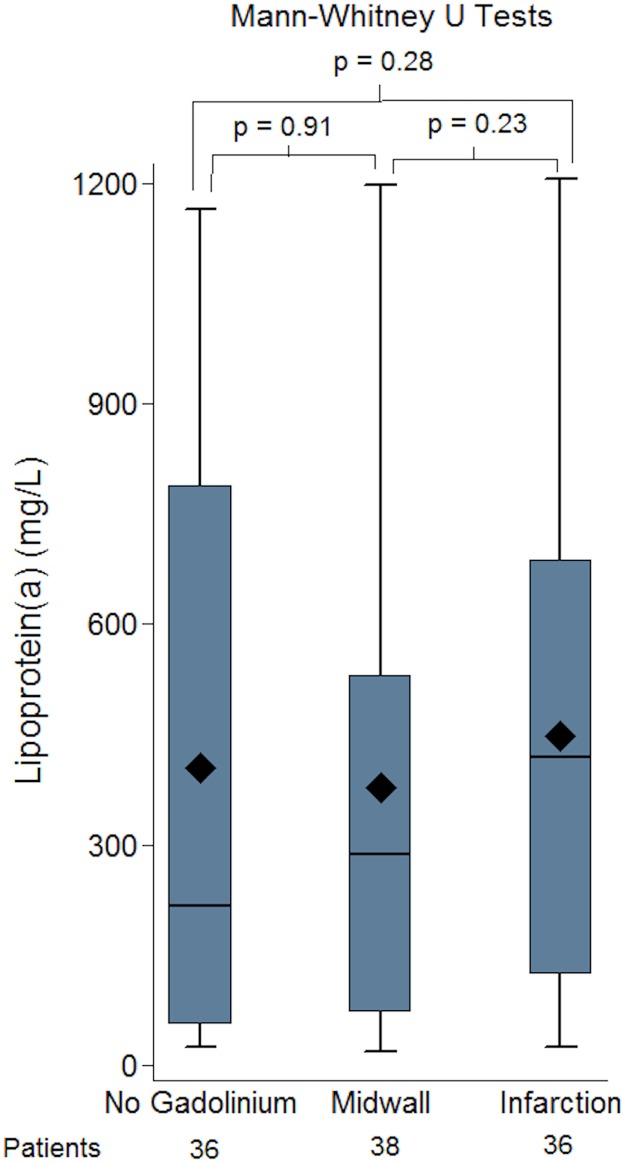
Values in the three groups (no fibrosis/no gadolinium, midwall fibrosis, infarction fibrosis) were compared and no significant difference between the groups was identified.We also assessed whether there was any association between the quantified mass or % enhanced myocardium for either midwall and infarction and Lp(a). There was no association between an increase in the enhanced absolute mass or % enhanced mass (defined by enhanced mass/overall mass) as shown in Fig 8.